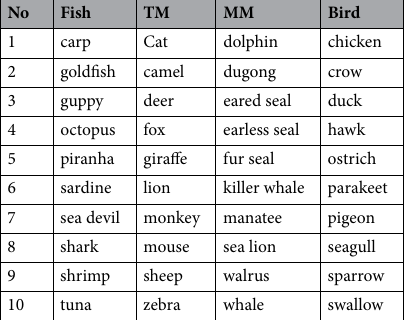
Table 1. Animals used as the stimuli. TM: terrestrial mammal; MM: marine